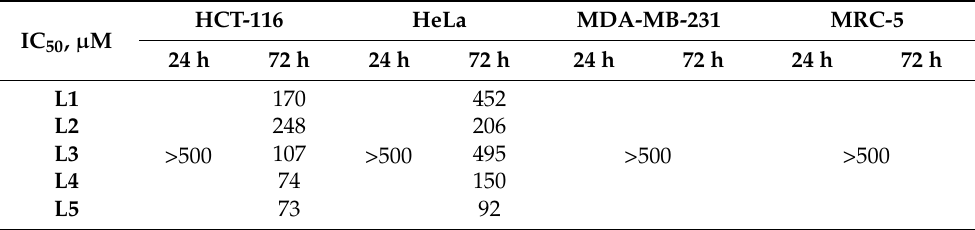
Table 5. The cytotoxic effects of L1 , L2 , L3 , L4 , and L5 after 24 and 72 h of exposure. HCT-116 HeLa IC 50 , µ M